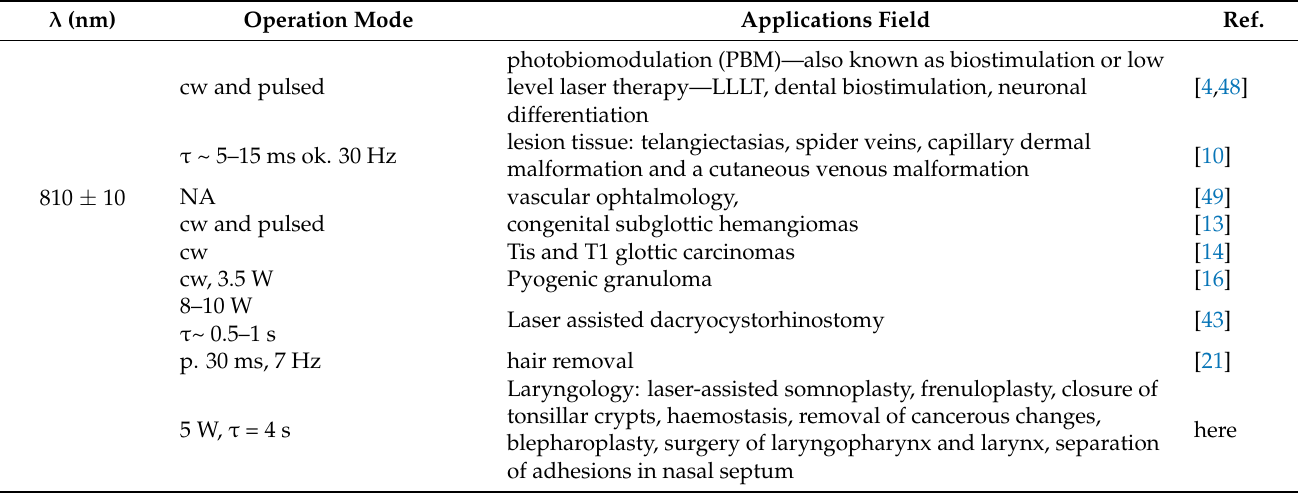
Table 1. Medical application of pulsed and cw diode laser with wavelengths 810 and 980 nm ( λ denotes wavelengths, τ pulse lengths).